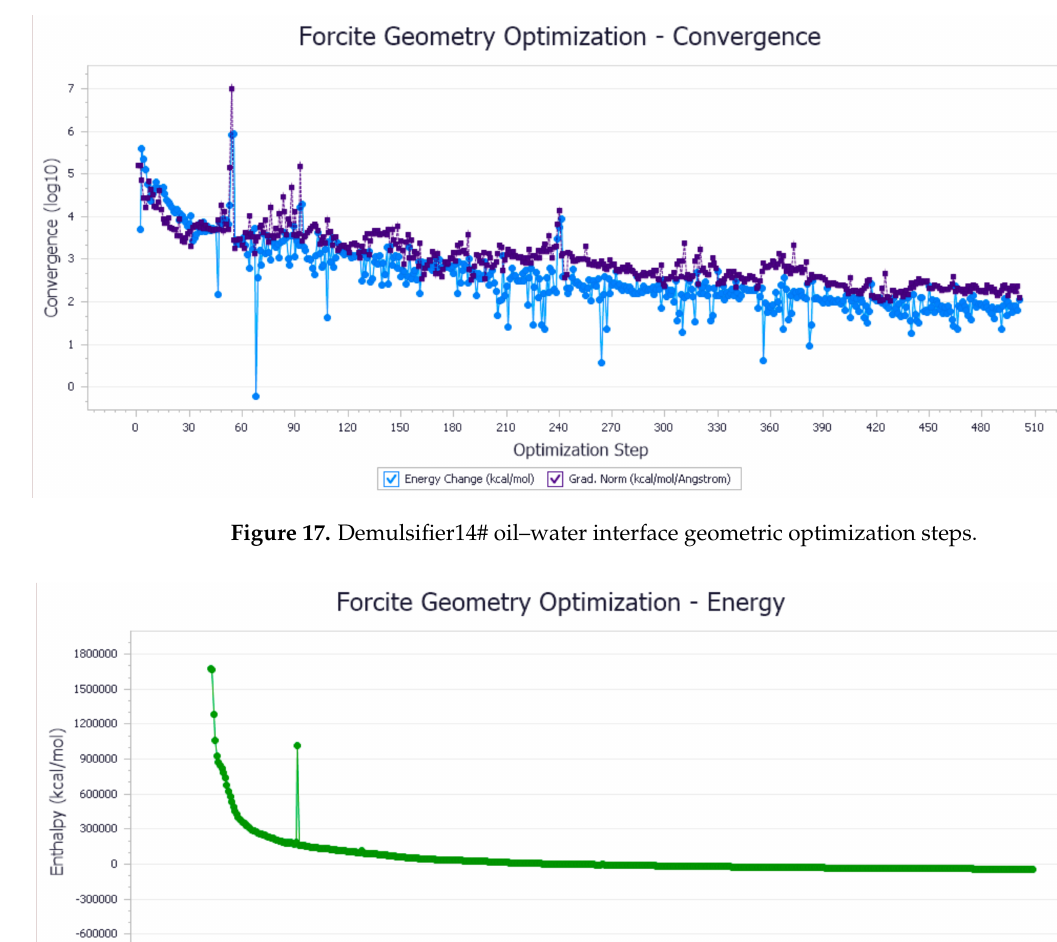
Figure 16. Demulsifier 12 # oil–water interface geometry optimization energy trend.